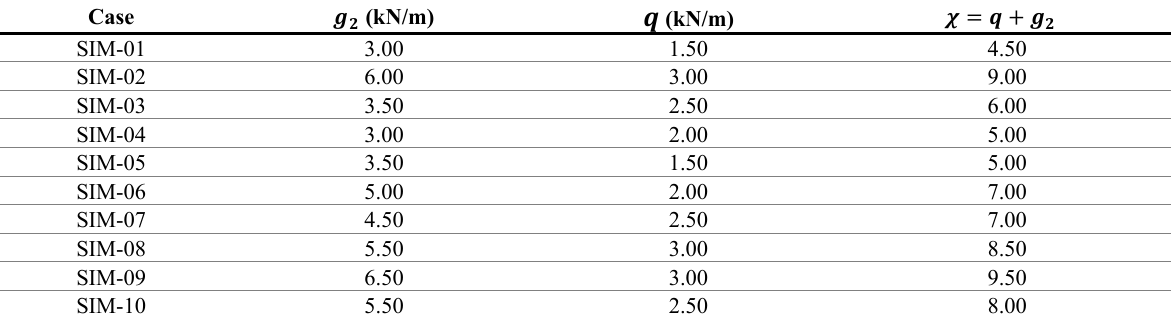
Table 6. Loading conditions for the